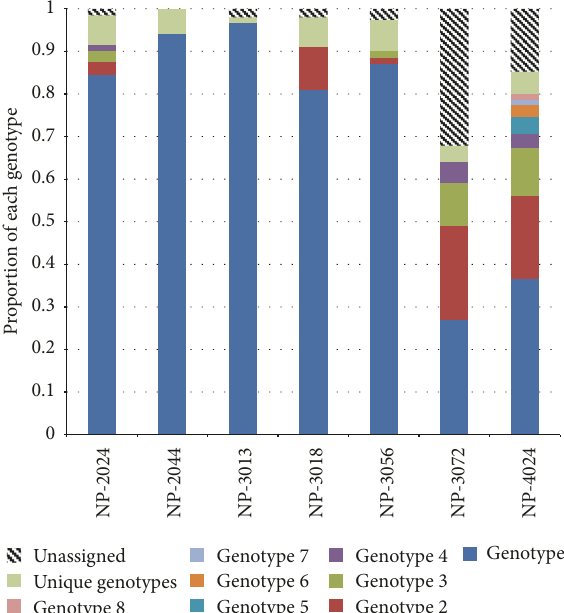
Figure 3: Diagram bars showing the mixture within the 7 “clonal accessions” from INIA’s EECA experimental station. For comparison purposes, data are expressed as a percentage of plants per